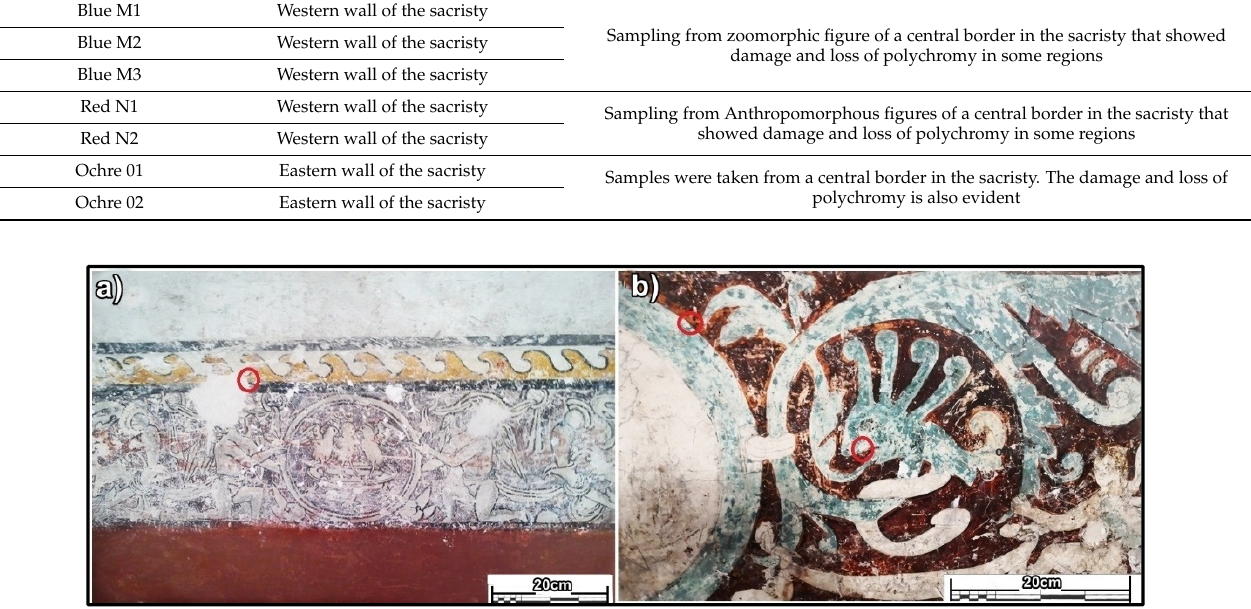
Table 1. Classification of the samples to be analyzed, and description and location of the sampling area. Num.